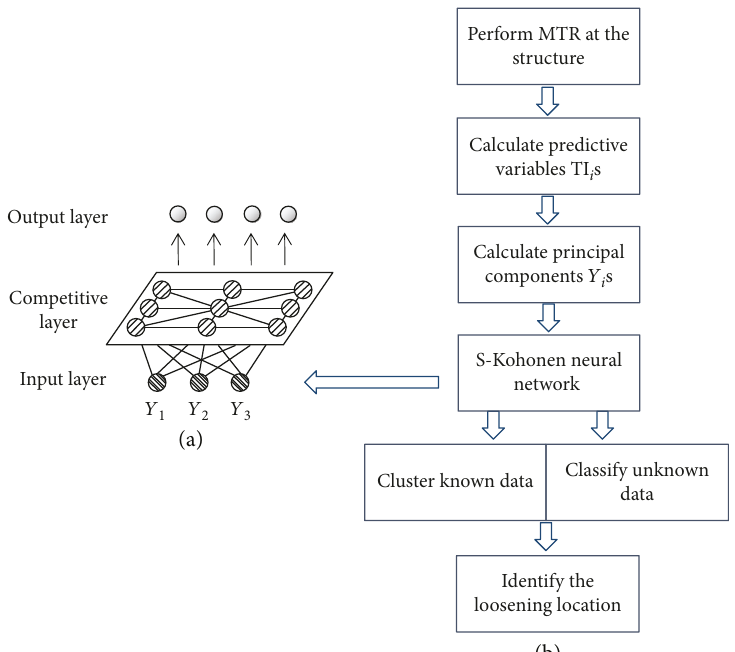
Figure 3: The schematic of the proposed method: (a) the topological structure of S-Kohonen network and (b) the fl ow chart of the loosening detection